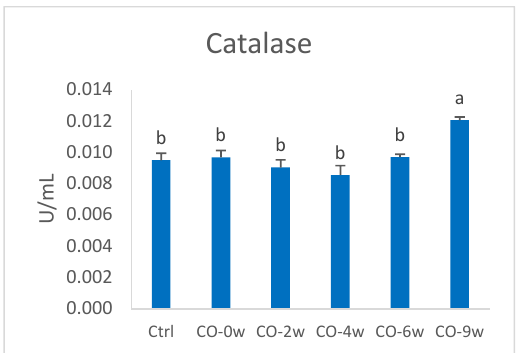
Figure 5. Catalase activity (U/mL) in HT29 cells exposed to oxidized camelina oil. All groups, except the control group (Ctrl), were cultured in growth media containing 0.5 mg/mL oxidized camelina oil for 72 h. Data (n = 4) are means shown with standard error mean. Significant differences are indicated with different letters evaluated with Tukey–HSD ( p < 0.05). CO = camelina oil; w = weeks.